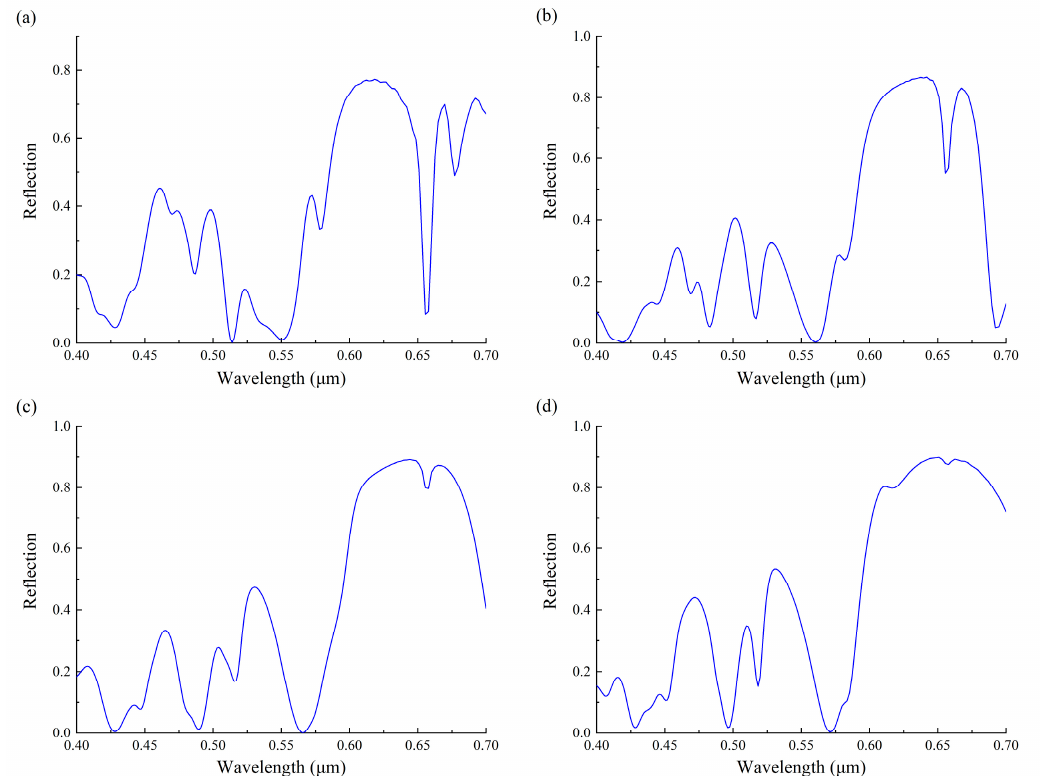
Figure 6. The reflection spectra of different H d . ( a ) The reflection spectra with H d = 30 nm. ( b ) The reflection spectra with H d = 60 nm. ( c ) The reflection spectra with H d = 90 nm. ( d ) The reflection spectra with H d = 120 nm.